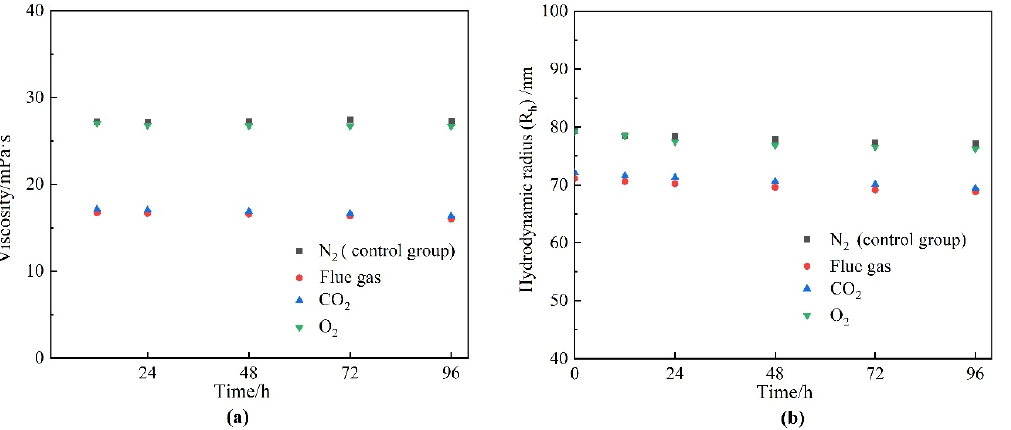
Figure 6. The effect of gas types on HPAM properties. ( a ) Viscosity; ( b ) hydrodynamic radius (R h ).